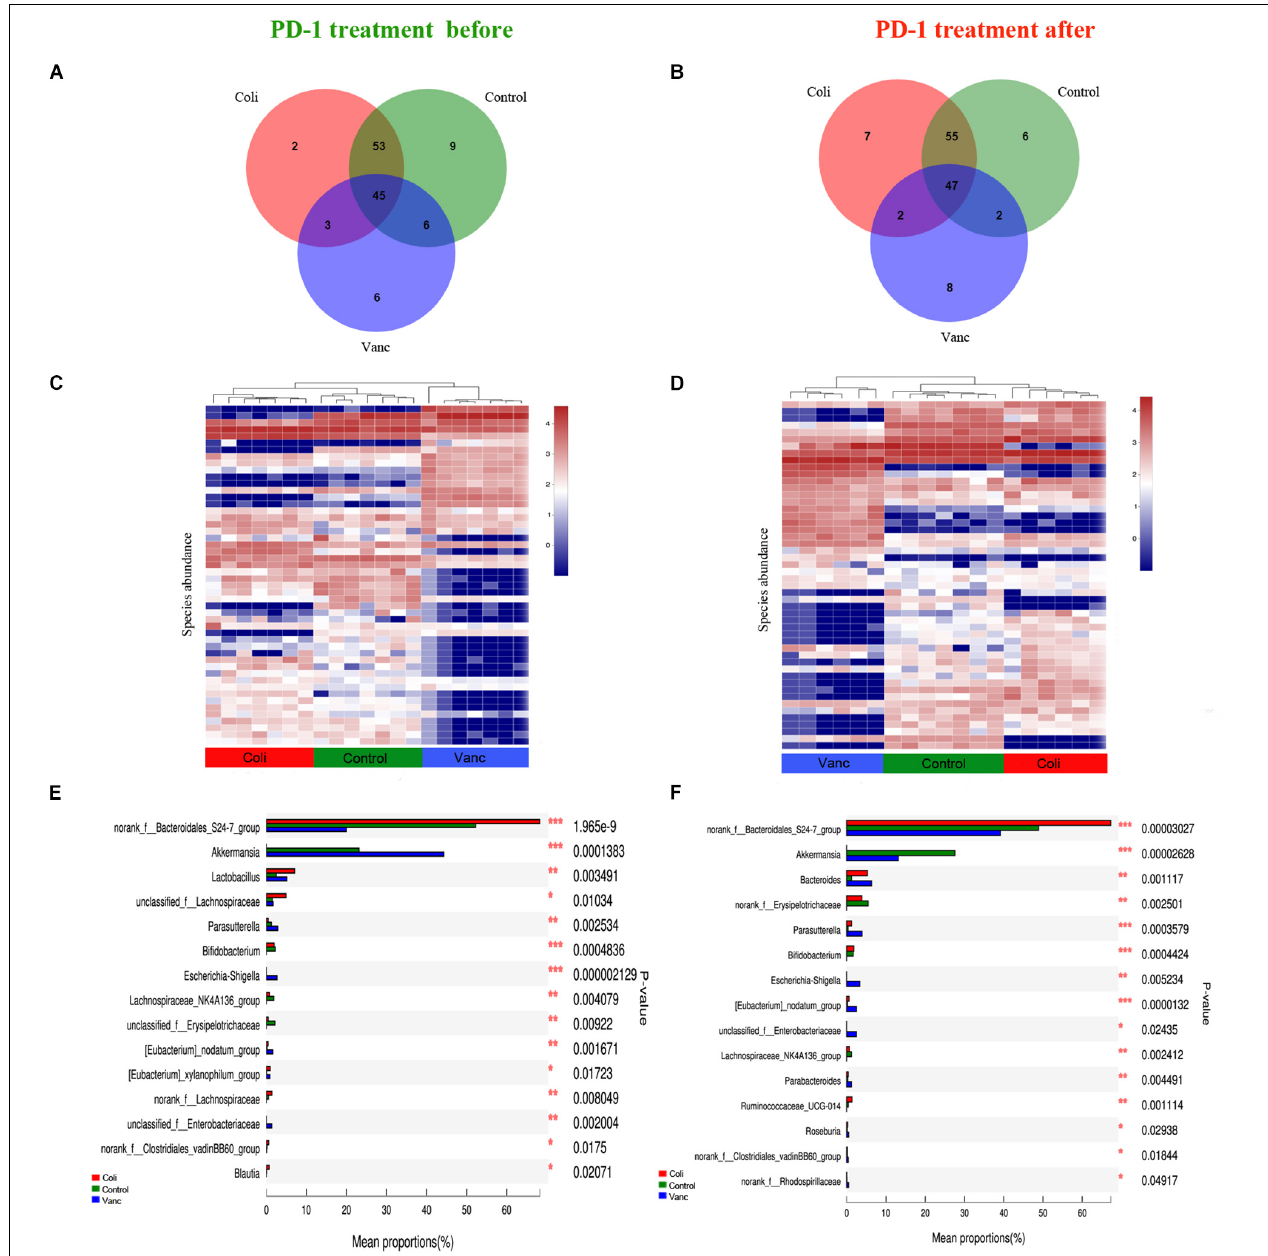
FIGURE 4 | Compositional differences in the gut microbiome are relatively stable over time. (A) Venn diagram of the total number of species shared between the three subgroups in before PD-1 antibody treatment group. (B) Venn diagram of the total number of species shared between the three subgroups in after PD-1 antibody treatment group. (C) Unsupervised hierarchical clustering of top 50 species abundances in before PD-1 antibody treatment group. (D) Unsupervised hierarchical clustering of top 50 species abundances in after PD-1 antibody treatment group. (E) Bar plot of compositional differences at genus level in the gut microbiome of before PD-1 antibody treatment group mice by one-way ANOVA. (F) Bar plot of compositional differences at genus level in the gut microbiome of after PD-1 antibody treatment group mice by one-way